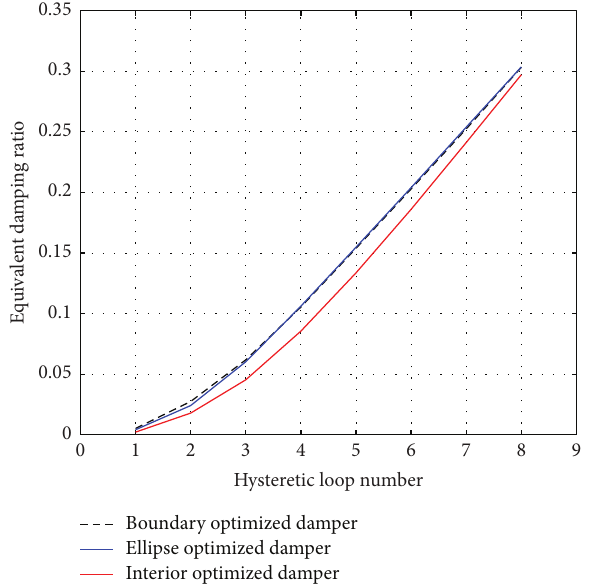
Figure 19: Comparison of equivalent damping ratio.